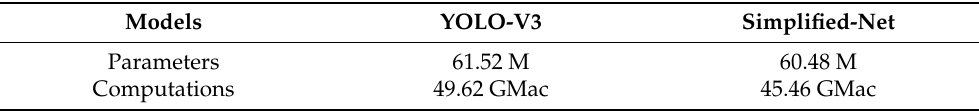
Table 2. Comparison between original and simplified